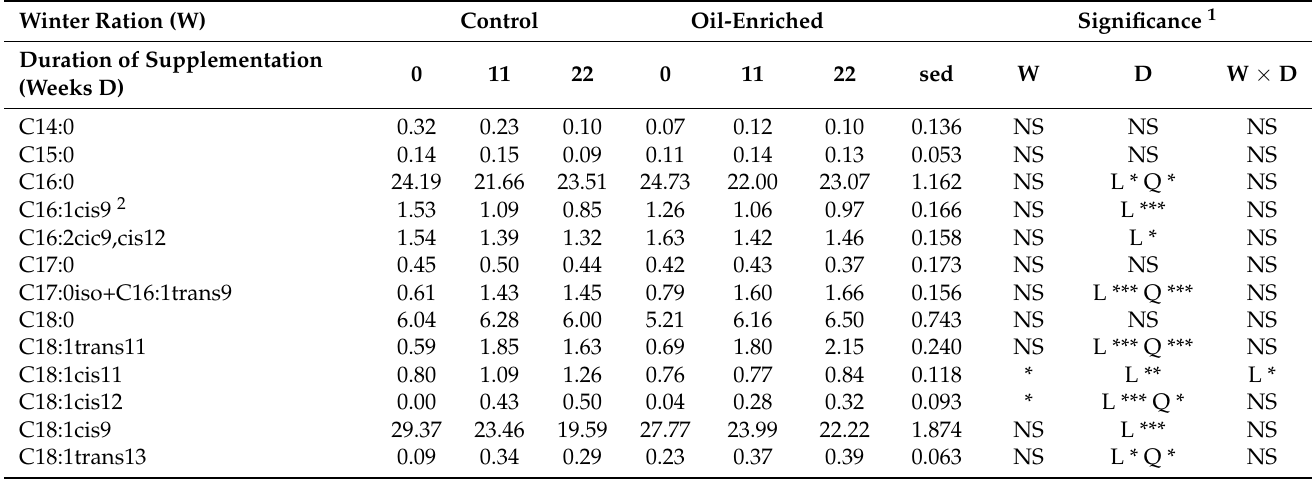
Table 9. Proportions of fatty acids in the polar lipid fraction of longissimus muscle of beef